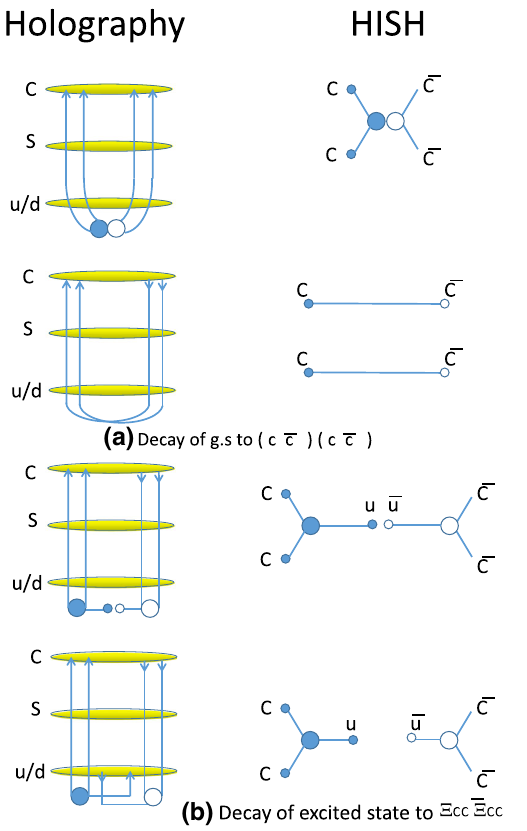
Fig. 3 a The decay of the ground state of a cc ¯ c ¯ c V- baryonium tetraquark to a pair of charmonia. b The decay of an excited state to a doubly charmed baryon and anti-baryon, both in holography (left figures) and in HISH (right